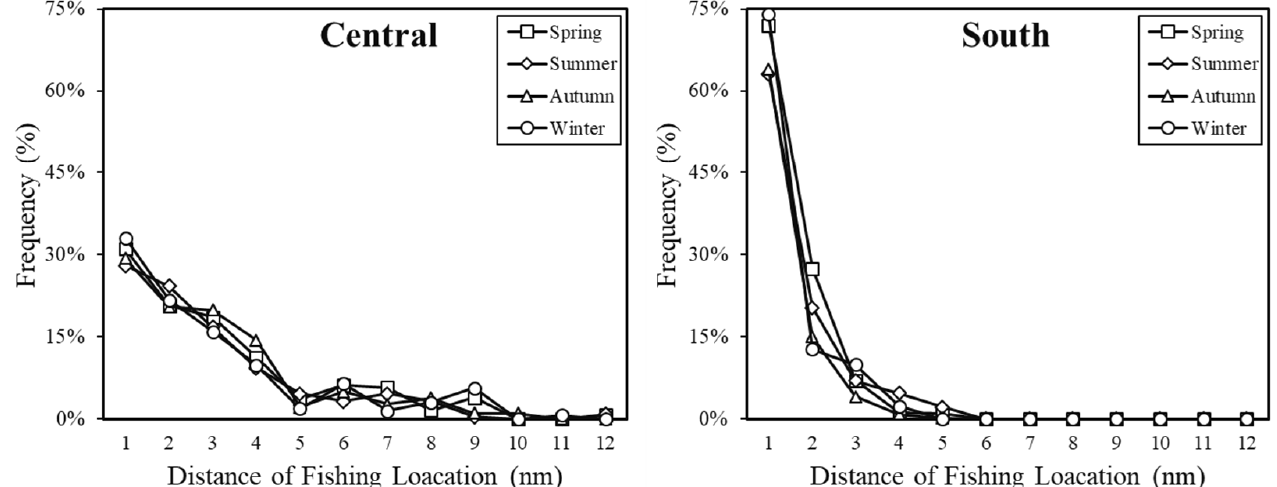
Figure 8. Distance of fishing location from the shoreline, as obtained by the sampling gillnet vessels for each season and area.